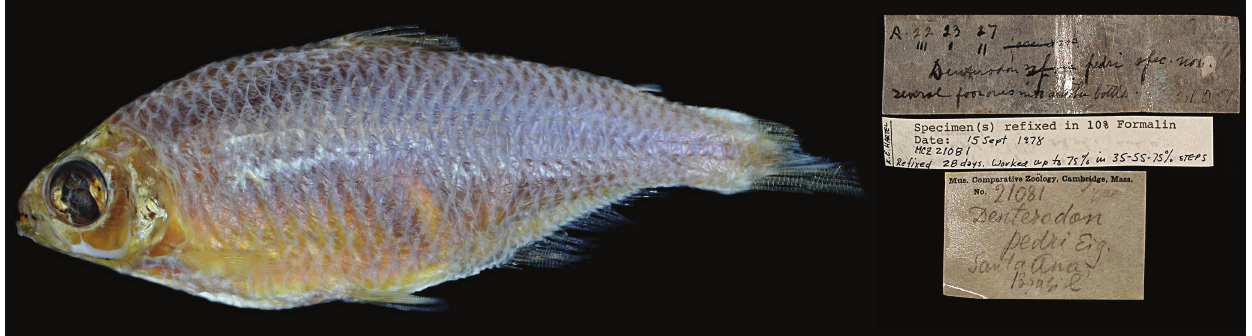
Fig. 1. Deuterodon pedri , MCZ 21081, lectotype, 78.56 mm SL and original labels. Material and